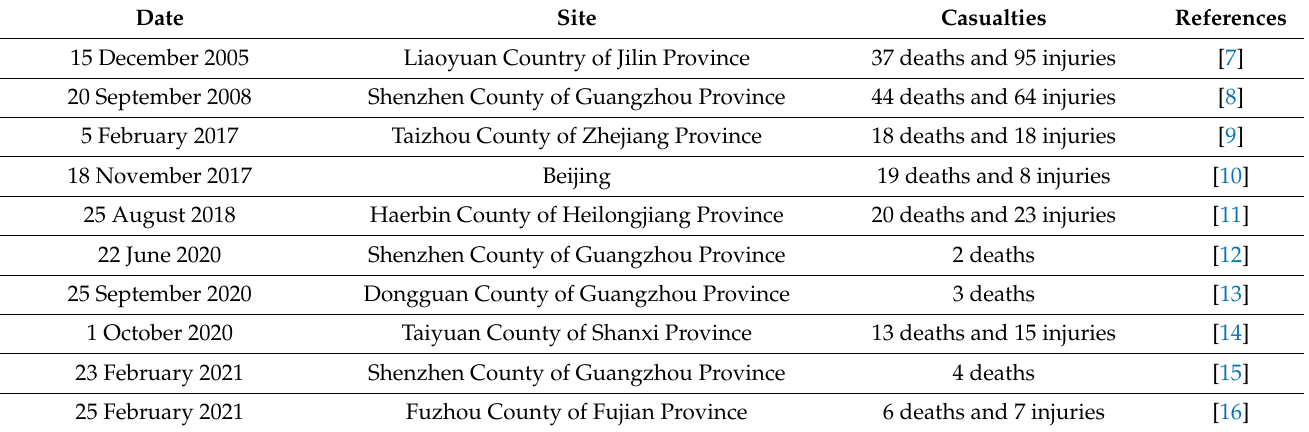
Table 1. Casualties of electrical fire accidents in various regions of China in recent